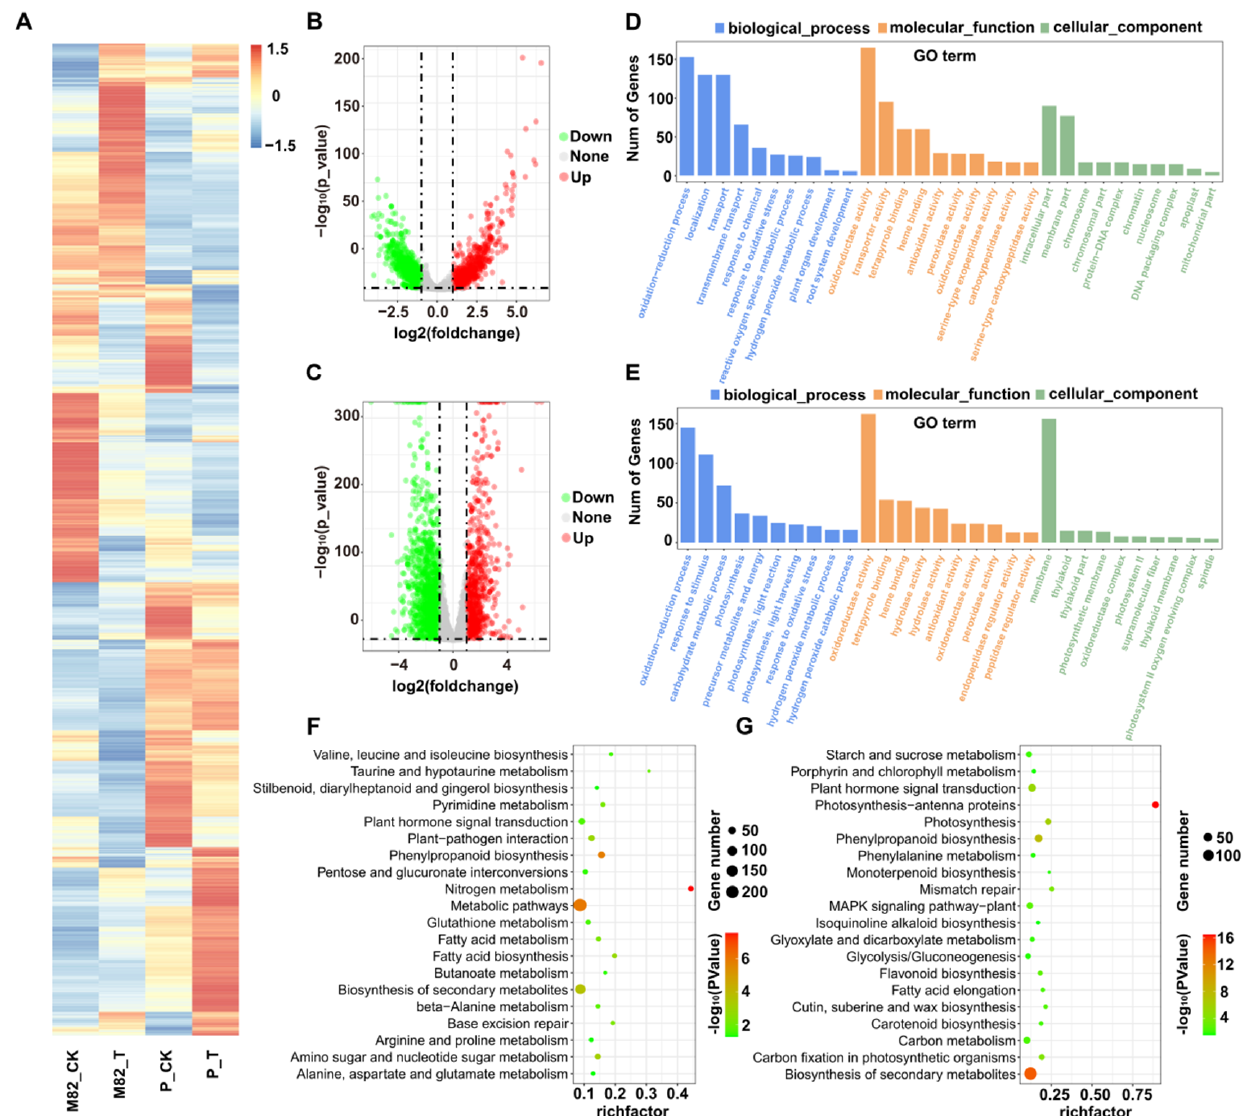
Figure 4. Identification of salt-responsive mRNAs in M82 and Solanum pennellii ( S. pennellii ). ( A ) The heatmap represents the expression patterns of all mRNAs. ( B ) The volcano plot represents the DE-mRNAs in M82, and the red and green circles represent the up-regulated and down-regulated mRNAs, respectively. ( C ) The volcano plot represents the DE-mRNAs in S. pennellii , and the red and green circles represent the up-regulated and down-regulated mRNAs, respectively. ( D , E ) GO enrichment analysis results for DE-mRNAs in M82 ( D ) and S. pennellii ( E ). ( F , G ) KEGG pathway analysis of DE-mRNAs in M82 ( F ) and S. pennellii ( G ).